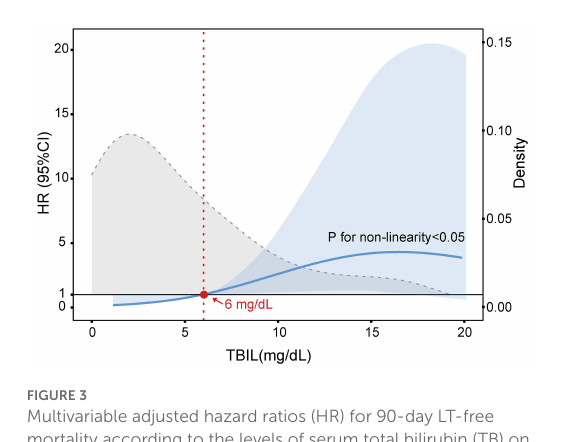
FIGURE3 Multivariable adjusted hazard ratios (HR) for 90-day LT-free mortality according to the levels of serum total bilirubin (TB) on a continuous scale in cirrhotic patients with AD and NIs. The blue line is multivariable adjusted HR, with light blue shaded area represent 95% CI. Dashed gray curve shows the fraction of population with different TB levels. Serum TB 6 mg/dL was selected as the reference level. Analyses were adjusted for overt ascites, neutrophil count, ALT, and INR at baseline.